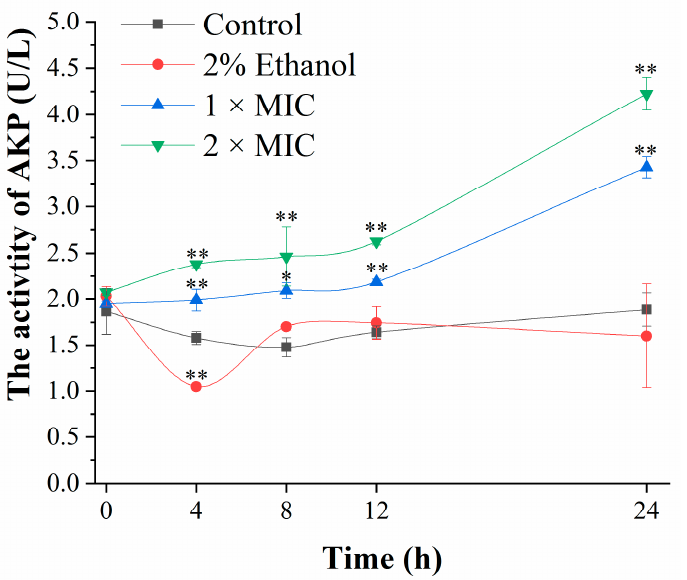
Figure 3. Alkaline phosphatase (AKP) activity of bacteria before and after 3-carene treatment. The asterisks indicate statistically significant differences compared with the control ( * p < 0.05; ** p < 0.01).